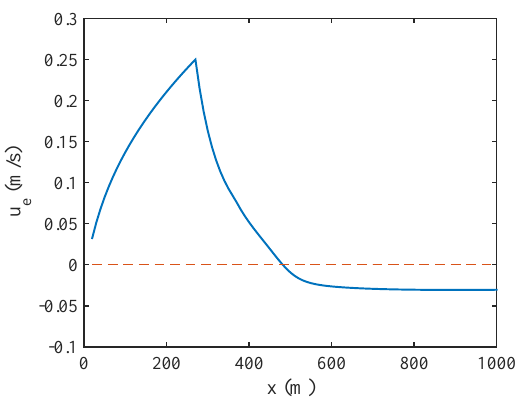
( x ) . The advection associated with the dispersion Figure 9. Effective subsurface velocity u e dominates. The crossover from positive to negative occurs approximately at x = 480 m.